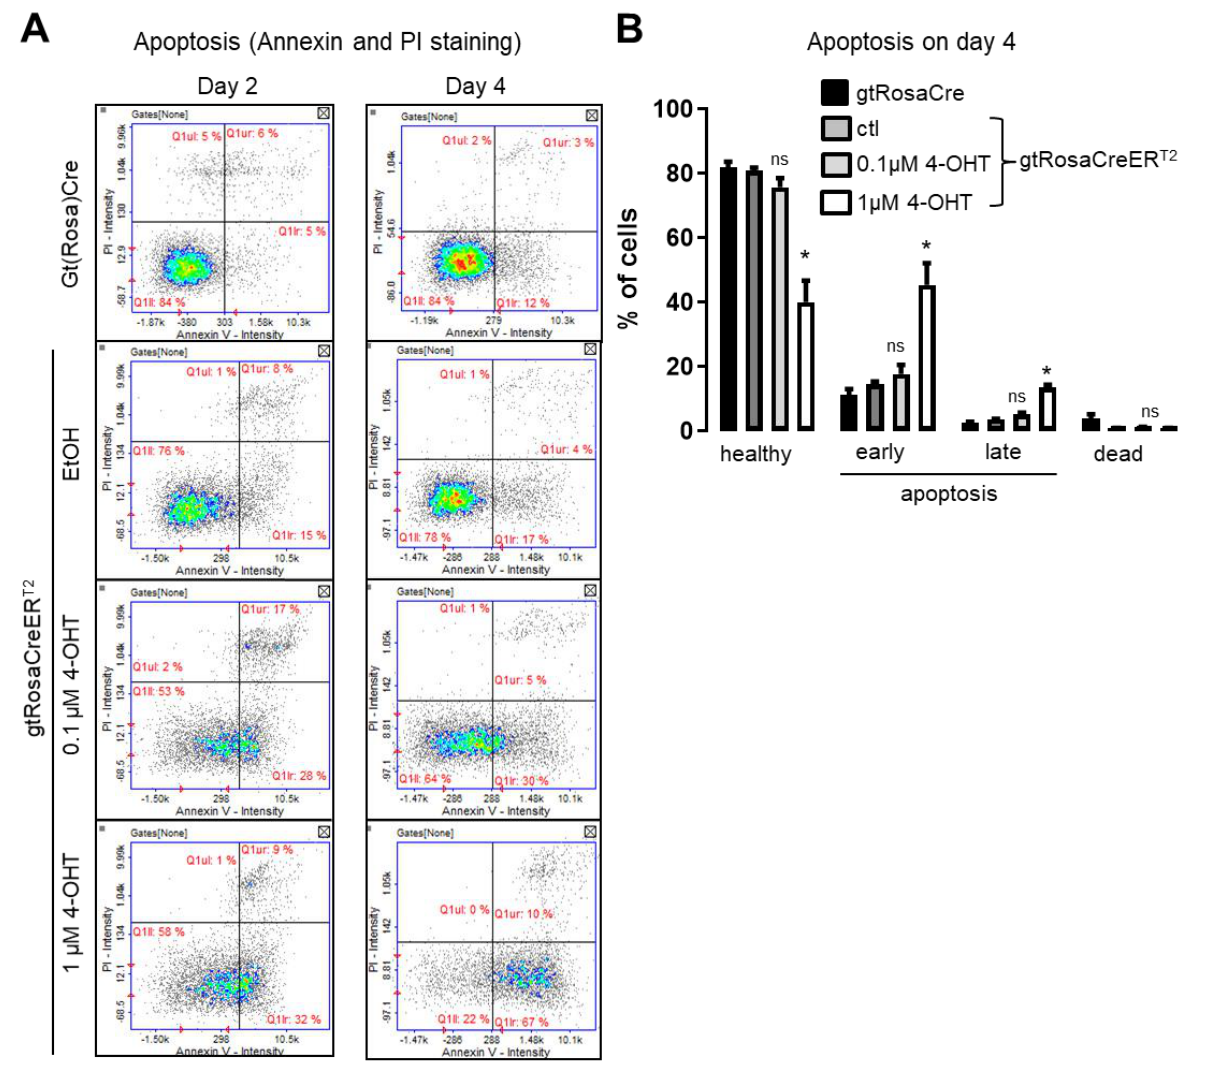
Figure 5. 4-OHT-induced Cre activity reduced cell numbers and induction of apoptosis. ( A ) An- nexin V Apoptosis Analysis using the Nucleo Counter NC-3000. Lower left panel depict healthy cells, lower right panel early apoptotic cells, upper right panel late apoptotic cells, upper left panel dead cells. ( B ) Annexin V Staining statistics of raw data. n = 6; mean with SEM; ns: none significant and * p < 0.05 EtOH vs. 4-OHT or gtRosaCre as indicated; 2-way Anova.